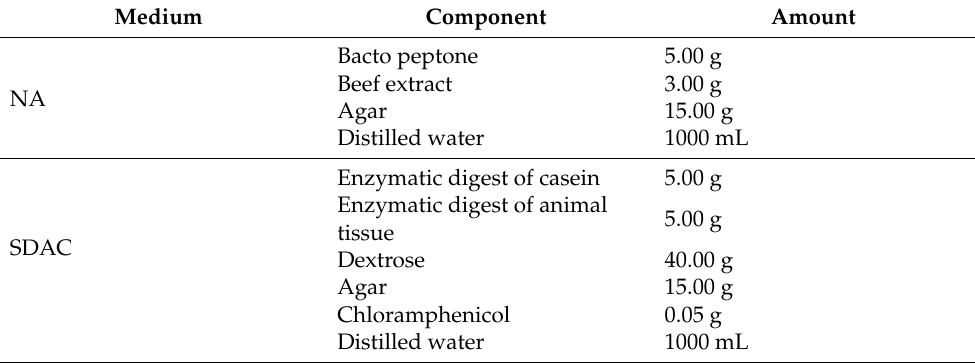
Table 1. Components of the growth